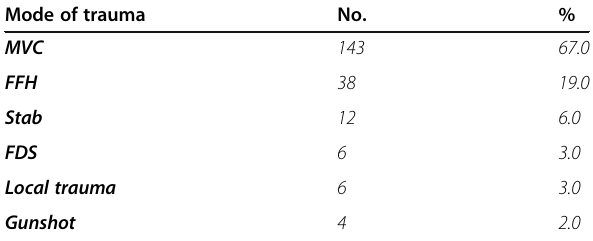
Table 2 Percentages of different types of chest